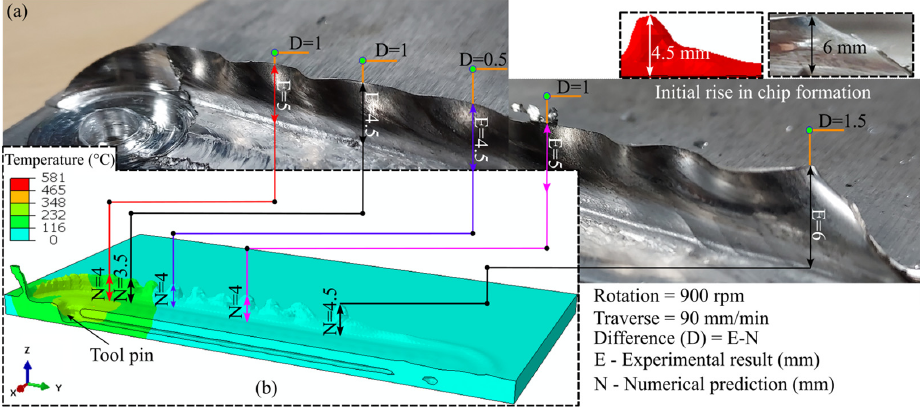
Figure 6. ( a ) The experimental investigation and ( b ) numerical modeling of flash formation on the retreating side at 900 rpm and 90 mm/min.